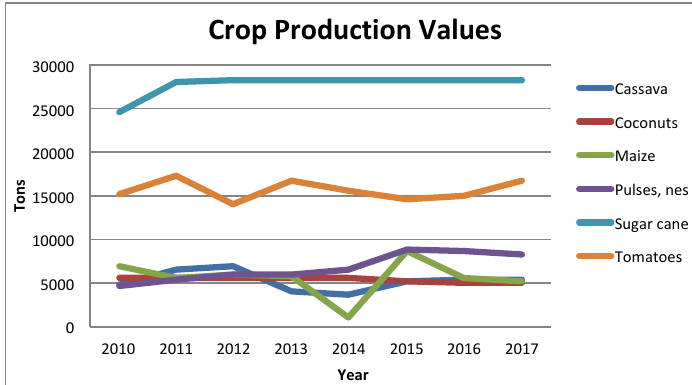
Figure 4. Production (in tons) of the top six agriculture commodities in Cabo Verde, from 2010 to 2017. Source: [48]. “Pulses, nes”, pulses that are not identified separately by species according to FAO [48].